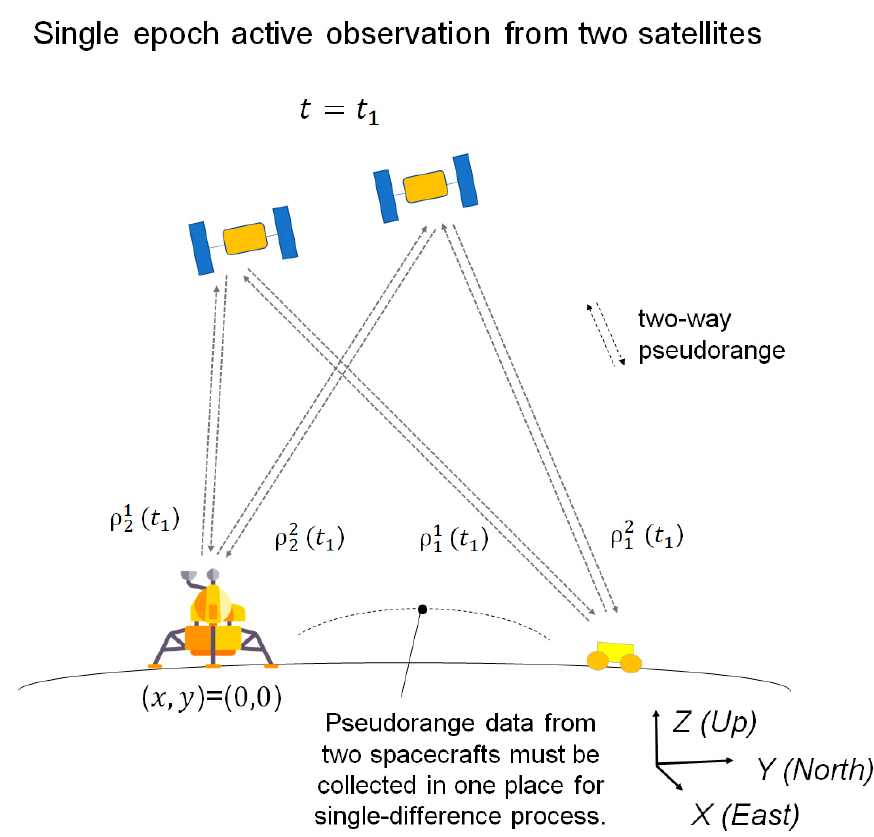
Figure 4. Overview of the single-differenced two-way ranging method.